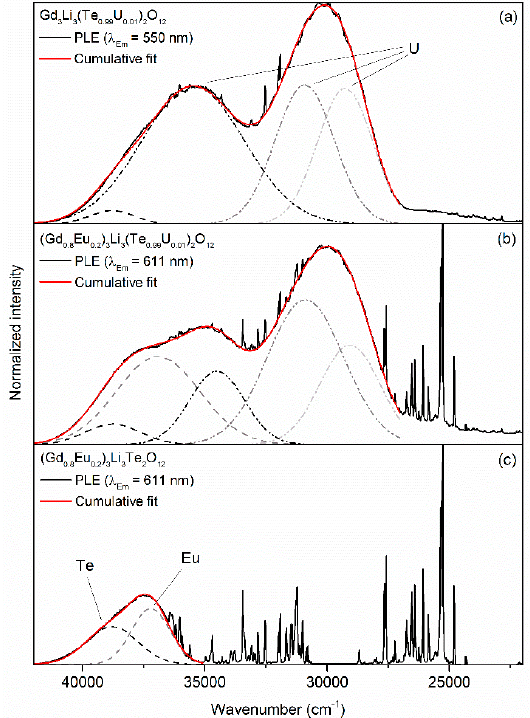
Figure 8. Excitation spectra with Gaussian distribution curves of ( a ) Gd 3 Li 3 (Te 0.99 U 0.01 ) 2 O 12 ; ( b ) (Gd 0.8 Eu 0.2 ) 3 Li 3 (Te 0.99 U 0.01 ) 2 O 12 ; and ( c ) (Gd 0.8 Eu 0.2 ) 3 Li 3 Te 2 O 12 at 3 K. Emission spectra of the solid solution according to (Gd 1 − x Eu x ) 3 Li 3 (Te 0.99 U 0.01 ) 2 O 12 with 0 ≤ x ≤ 1 are